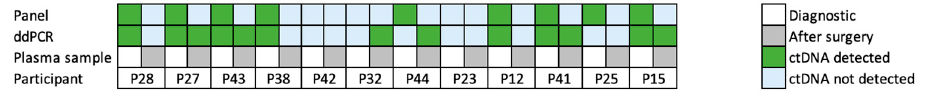
Figure 7. Heatmap of ddPCR results in relation to gene panel results. The ctDNA detection with targeted panel sequencing is compared to detection with ddPCR of one or two selected target variants. Green represents detection of ctDNA with the specific method, and light blue represents no detection of ctDNA. Both the diagnostic plasma sample (white box) and the sample from after surgery (grey box) are shown. For most samples, ddPCR is the most sensitive method. ddPRC, digital droplet PCR; PCR, polymerase chain reaction; ctDNA, cell-free tumour DNA. The ddPCR could detect its target in 10 out of the included 12 participants (Table 3).